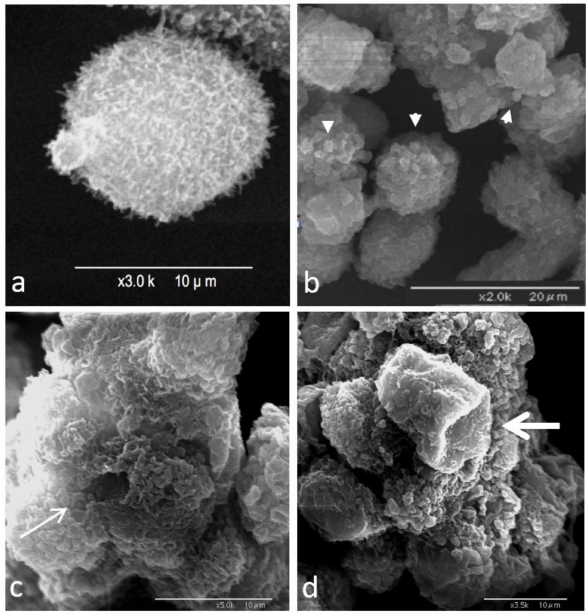
Figure 8. Scanning electron microscopy image of TOS-1 renal cell carcinoma. ( a ) Control TOS-1 cell in suspension covered with microvilli. ( b ) Bleb formation on the surfaces of the shock-wave-treated cells (arrowheads). ( c ) Hole formation in the cell membrane of the treated cells (thin arrow). ( d ) Collapse of the cell membrane due to damage to the underlying cell cytoskeleton (thick